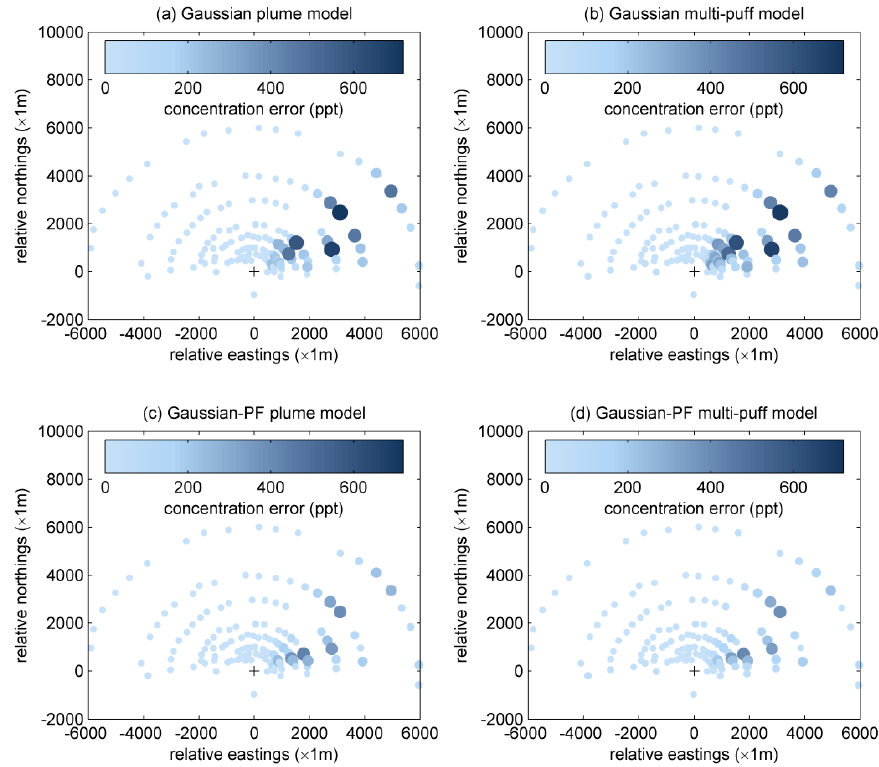
Figure 4. Distribution of concentration error of monitoring sensors at 10:00 calculated by ( a ) Gaussian plume model; ( b ) Gaussian multi-puff model; ( c ) Gaussian-PF plume model, and ( d ) Gaussian-PF multi-puff model. Table 4. Average computational time of each model.